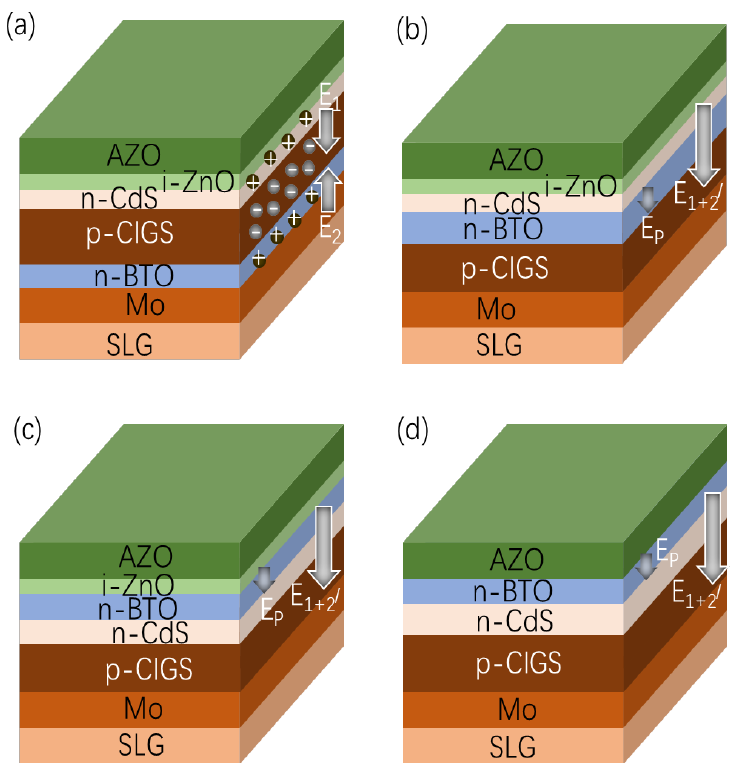
Figure 14. The different device structures of CIGS cells (not drawn to scale) and the schematic diagram of the electric field induced by the polarized BTO thin film and the field-assisted carrier separation. ( a ) SLG/Mo/BTO/CIGS/CdS/i-ZnO/AZO/Au, ( b ) SLG/Mo/CIGS/BTO/CdS/i-ZnO/AZO/Au, ( c ) SLG/Mo/CIGS/CdS/BTO/i-ZnOAZO/Au, and ( d ) SLG/Mo/CIGS/CdS/BTO/AZO/Au.